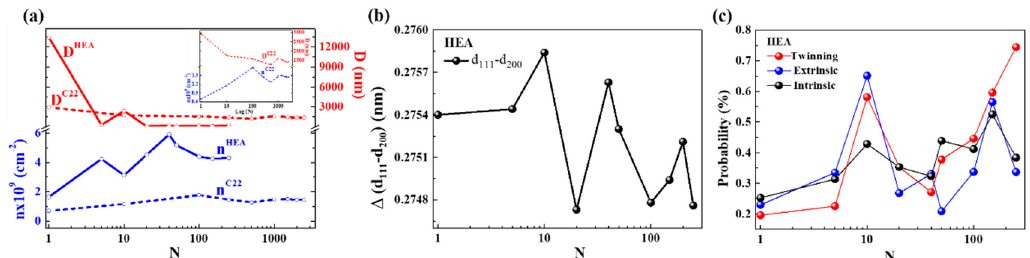
Figure 4. ( a ) The dislocation density and dislocation-wall-spacing evolution in C22™ and CoCrFeMnNi alloys. The magnification of n and D of C22™ alloy is indicated in the inset. ( b ) The difference in d-spacing between diffraction peaks 111 and 200 of CoCrFeMnNi. ( c ) Twining, extrinsic and intrinsic stacking faults defects as a function of fatigue cycle (presented in log scale) in CoCrFeMnNi.